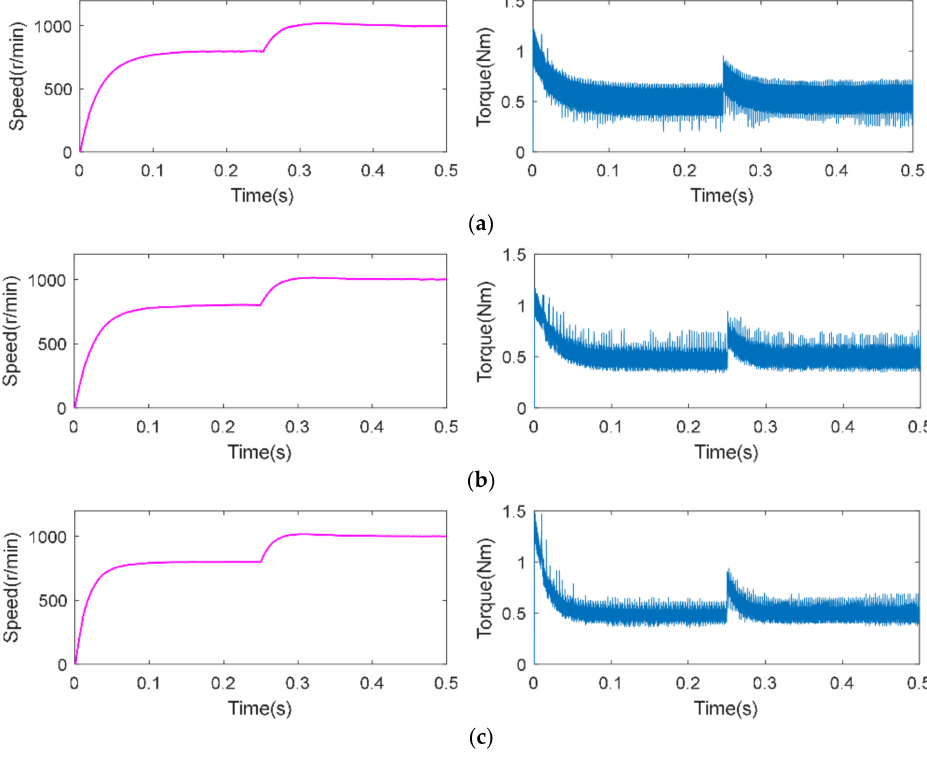
Figure 10. Speed and torque under speed change. ( a ) Method 1, ( b ) method 2, and ( c ) method